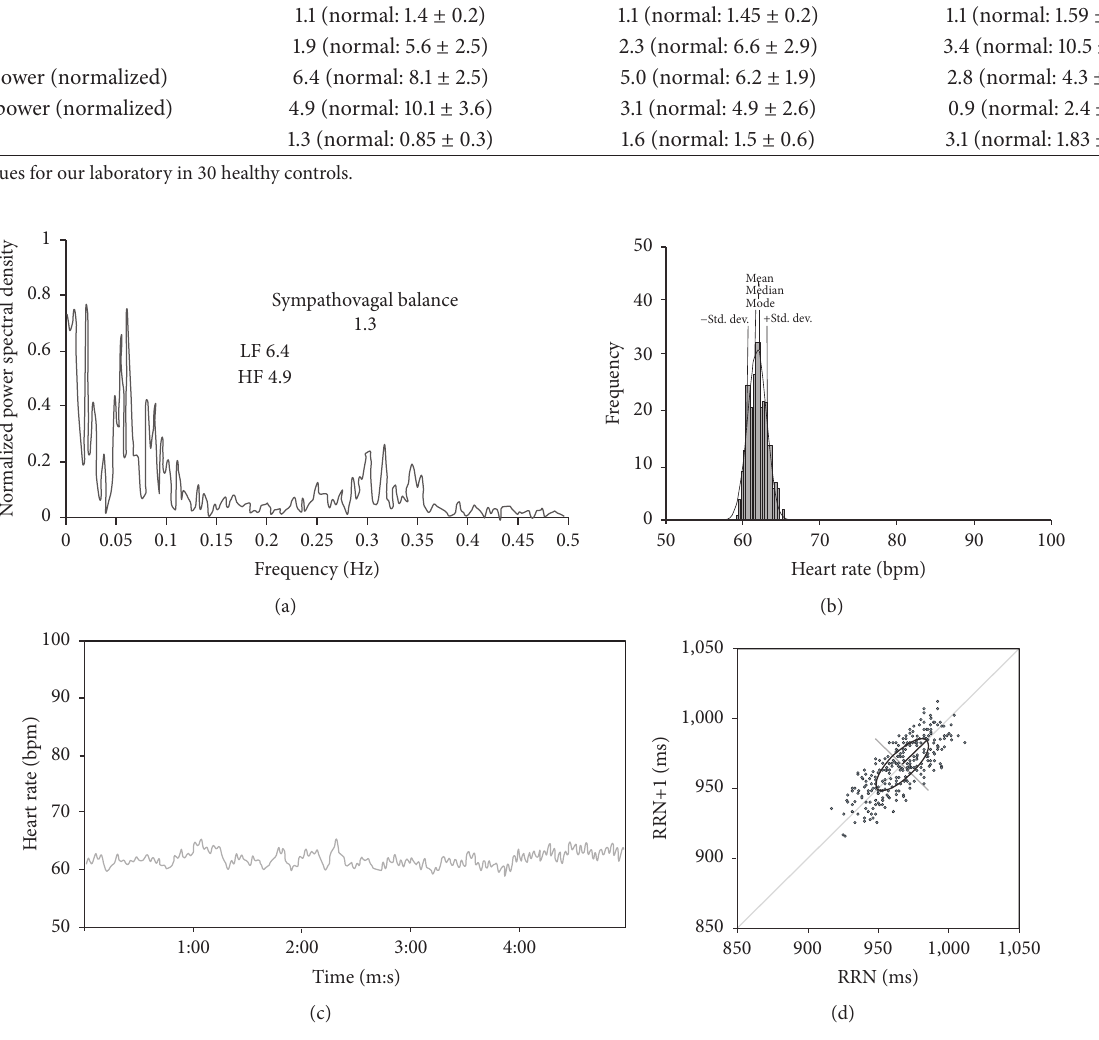
Figure 2: HRV in the supine position. (a) The total Fourier spectrum, (b) the histogram, (c) the tachogram, and (d) the Poincar´e plot. The sympathovagal balance (SVB = LF/HF) was 1.31 versus 0.85 ± 0.3 in controls. The total power of LF was 6.4 versus 8.1 ± 2.5 in controls, and the total power of HF 4.9 versus 10.1 ± 3.6 in controls. The tachogram, the histogram, and the Poincar´e plot show a loss of variability across all